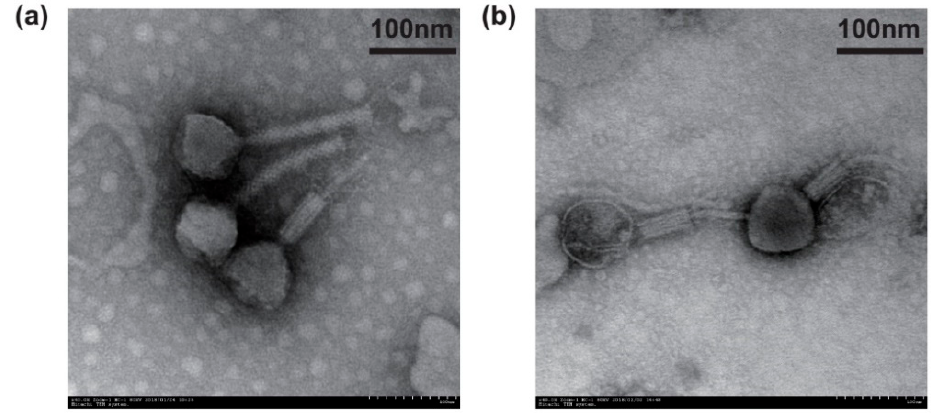
Figure 1. Transmission electron microscopy images of phages ( a ) vB_PaeM_SCUT-S1 and ( b ) vB_ PaeM_SCUT-S2 negatively stained by 2% phosphotungstic acid.